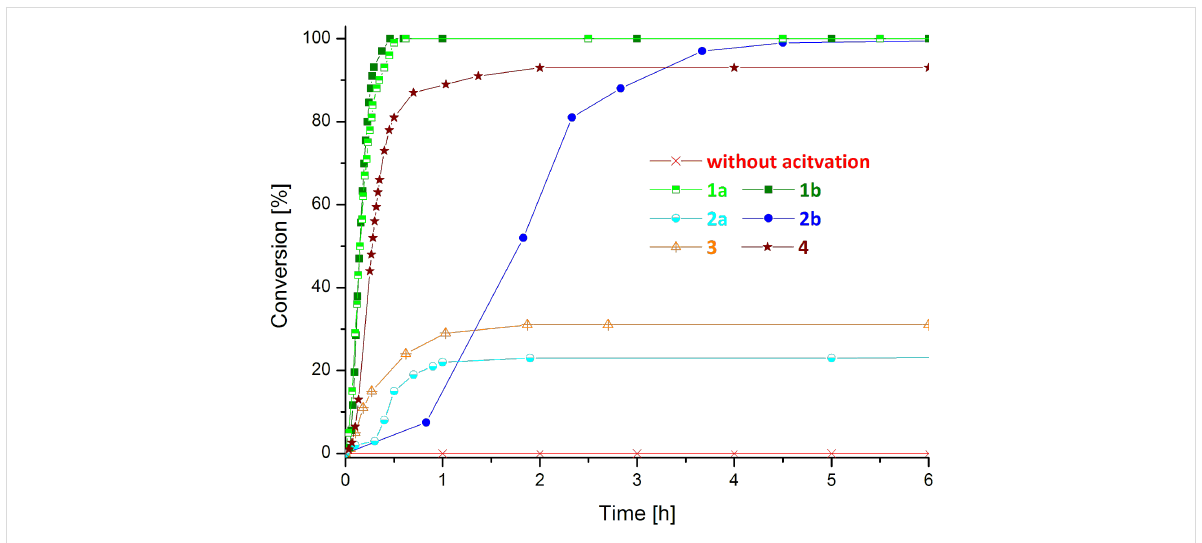
Figure 2: Time/conversion plot for the polymerization of 5 by preinitiators 1 – 4 in the presence of HCl ([ 5 ]:[HCl]:[I] = 50:25:1; [ 5 ] = 0.1 mol/L; solvent:CDCl 3